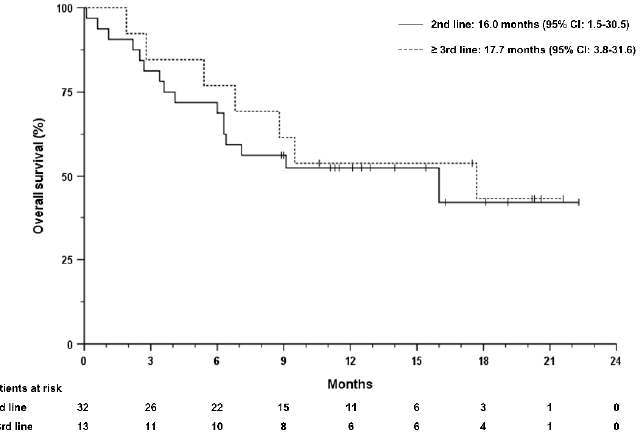
Figure 2. Progression-free survival of the overall study cohort, independent of the therapy line. Pro- gression-free survival as the time from treatment start to radiographic progression or death from any cause. Tick marks indicate censored data.